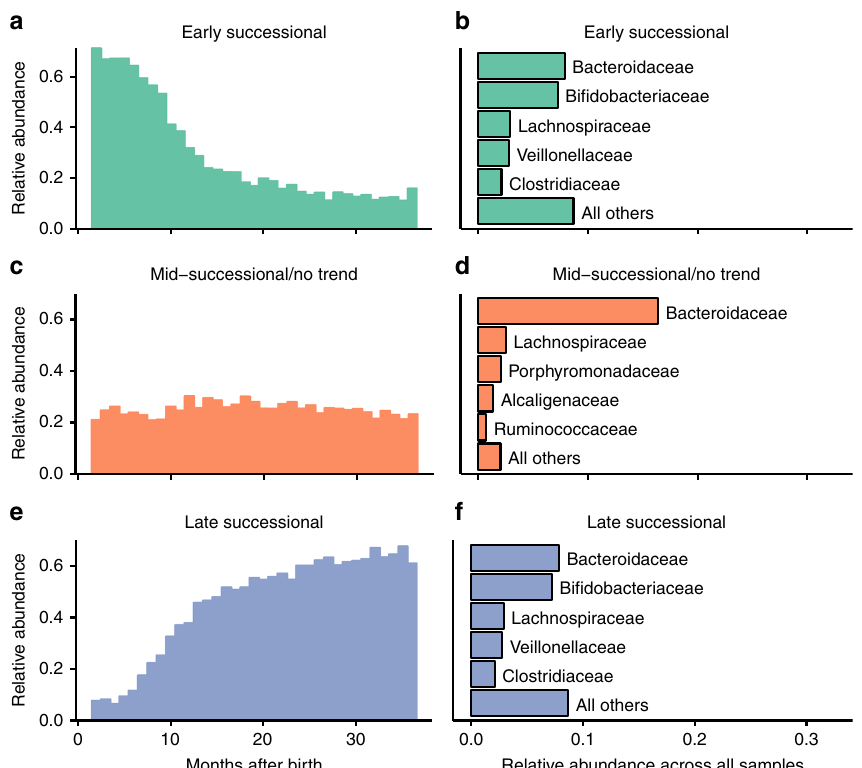
Fig. 1 OTU abundances over gut succession. OTUs were placed into one of three successional groups based on their average trends in abundance across 56 infants over development. Taxa were categorized as early successional if their abundances increased signi fi cantly over time ( p < 0.05), and late successional if their abundances decreased signi fi cantly over time, based on linear regressions; OTUs that did not trend signi fi cantly over time were placed into a mid-successional or no-trend category. a , c , and e Combined relative abundances of the OTUs of each successional category over time. b , d , and f The fi ve most commonly-represented families among the OTUs of each successional category, and their total relative abundances over the entire sampling